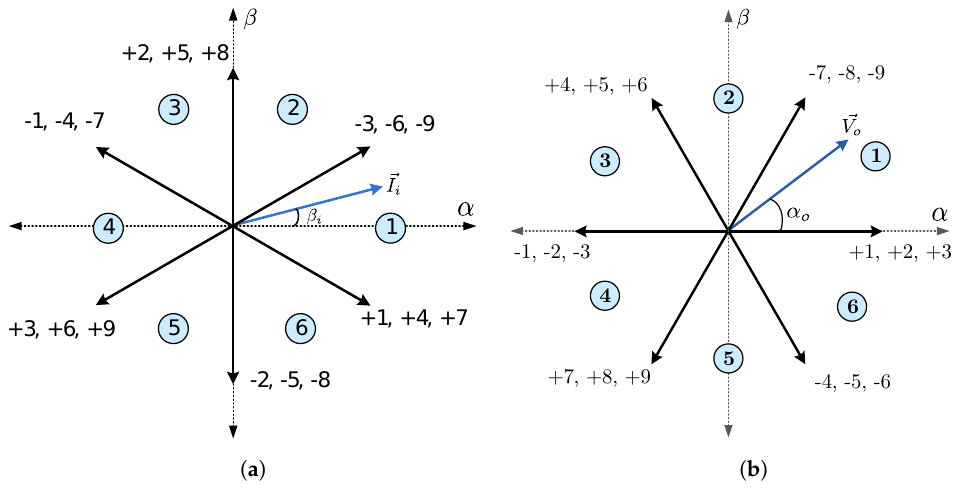
Figure 3. Vectors grouped in the Alpha–Beta plane. ( a ) Input current. ( b ) Output voltage. The amplitudes of the voltage vectors and current in a matrix converter vary with the currents in the current port and with the line voltages in the voltage